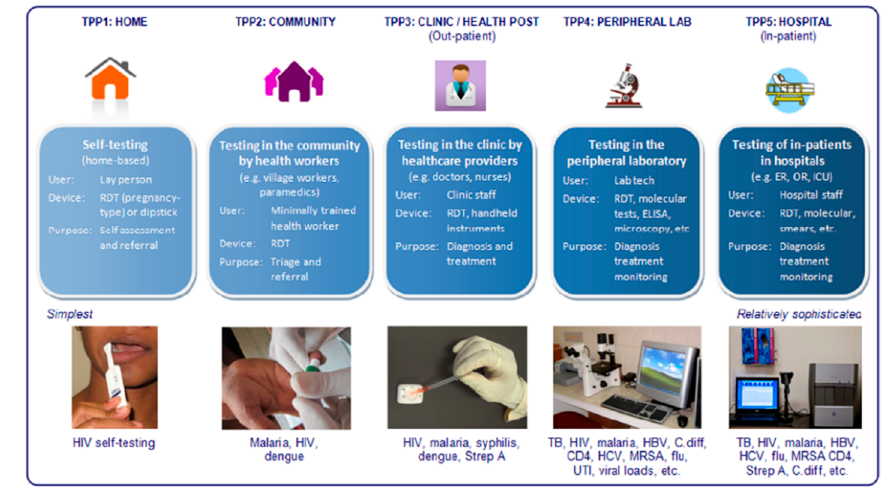
Figure 2. Pai et al., investigated PoC use within different usage scenarios. Figure adapted from [5] with permission under open-access copyright agreement.